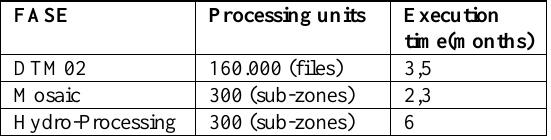
Table 2. Processing cost